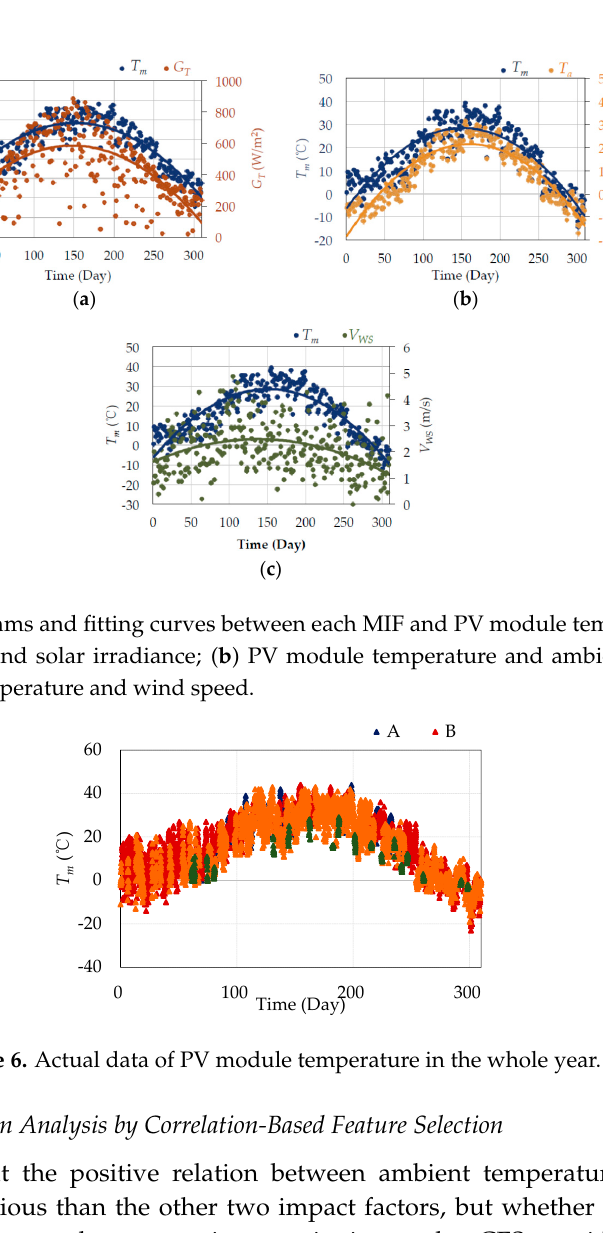
Figure 4 . Actual data of PV module temperature and meteorological impact factors (MIFs) under